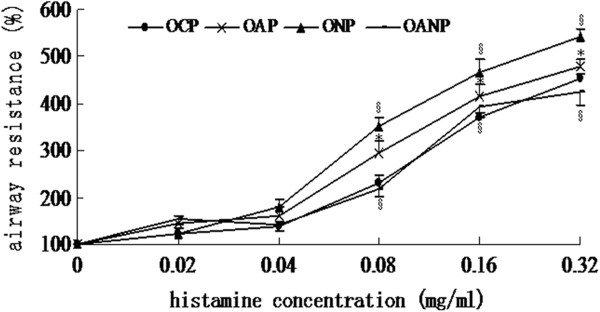
Changes in airway resistance to histamine in offspring rats. Rats were treated with increasing doses of aerosolized histamine. Afterwards, airway resistance was calculated as the percent of change in resistance at the peak of the reaction with reference to the baseline value. The values were expressed as mean ± SD (n = 8). *Indicates a significant difference compared to the OCP group (P < 0.05). § Indicates a significant difference compared to the OAP group (P < 0.05).